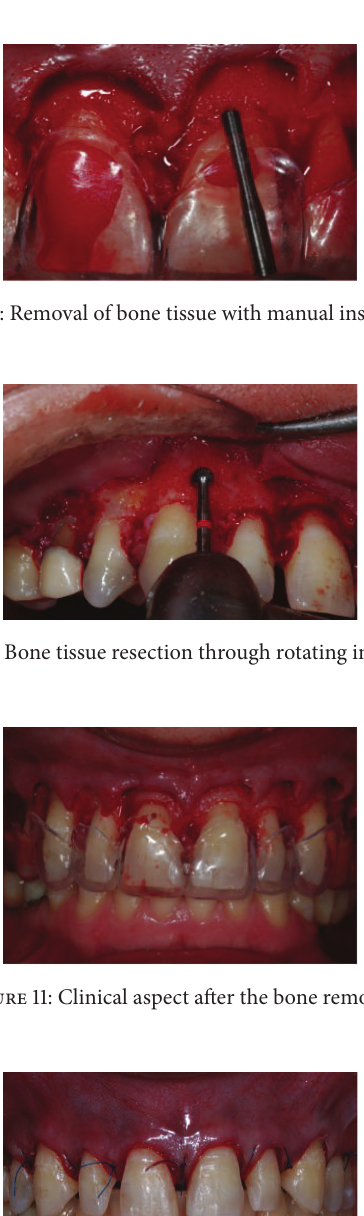
Figure 13: Clinical aspect of soft tissues after six-month follow-up.